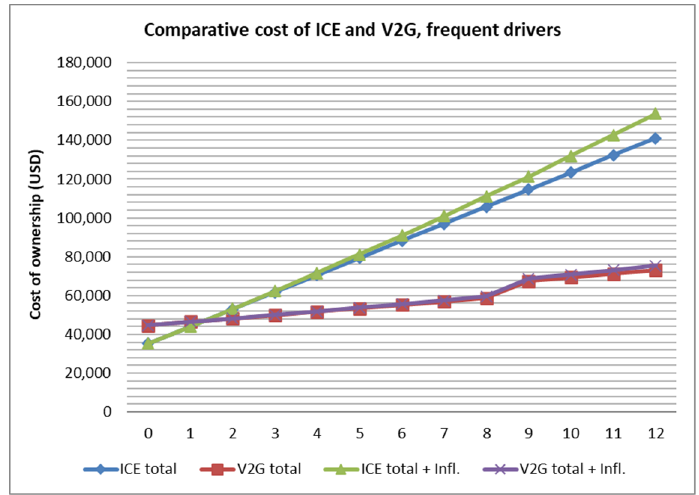
Figure 4. Graphical representation of the calculation results for frequent drivers.